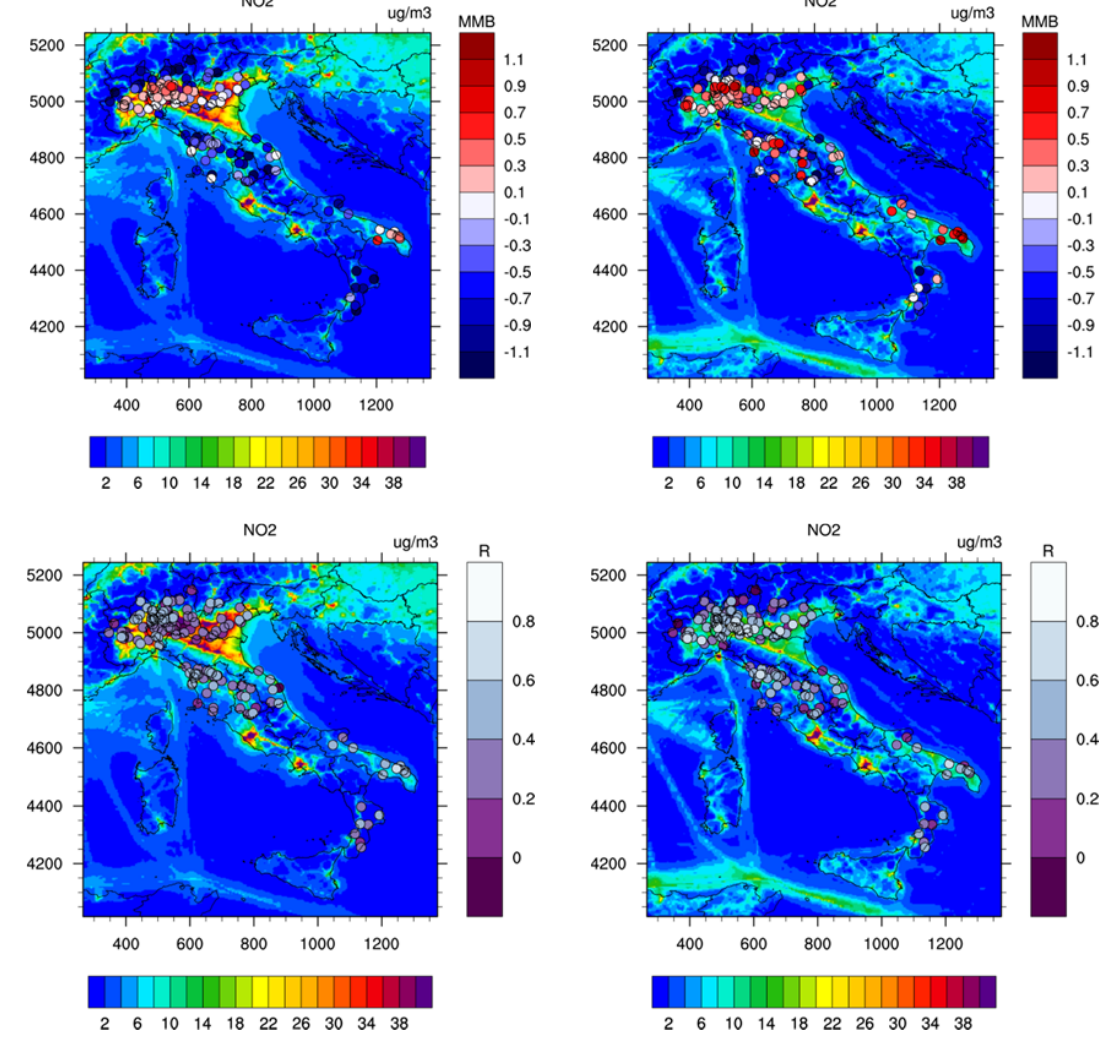
Figure 7. NO 2 —Monthly average of model concentrations of January (left) and August (right) for the WRF Base configuration, overlaid with monthly values of MMB (upper panel) and R (lower panel) at monitoring stations. Model concentrations have a horizontal colour bar ( µ g / m 3 ), skill scores have a vertical colour bar (non ‐ dimensional).